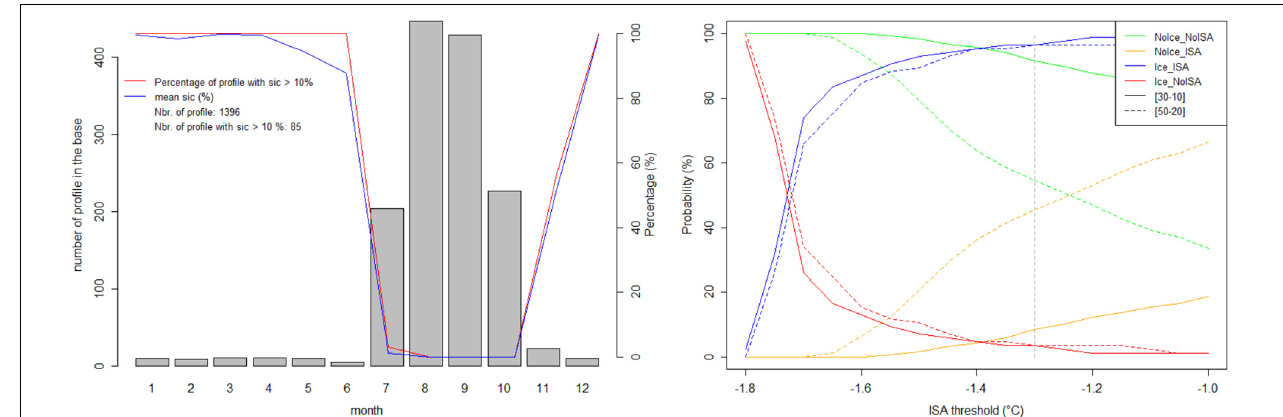
FIGURE 6 | Left : In gray, distribution of float profiles over months included in the database. In red, percentage of profiles with Sea Ice Concentration ( SIC ) > 10%; in blue, mean SIC in percent. Right : NoIce_NoISA (probability to have no sea ice and negative ISA), NoIce_ISA, Ice_ISA (probability to have sea ice, and positive ISA), and Ice_NoISA statistics in function of the Ice-Sensing Algorithm (ISA) temperature threshold and for the temperature median processed between 50 and 20 dbars (dashed lines) or between 30 and 10 dbars (solid lines). Chosen threshold is –1.3 ◦ C (gray dashed line) and best depth range is 30-10 dbars.